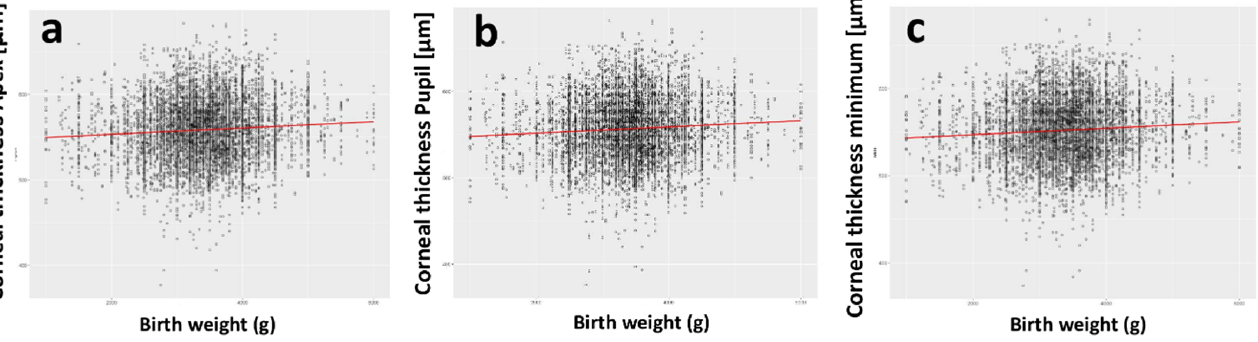
Figure 1. Scatterplot of birth weight with ( a ) corneal thickness in the apex, ( b ) corneal thickness in the pupil center, ( c ) minimal corneal thickness in the Gutenberg Health Study ( n = 5657).